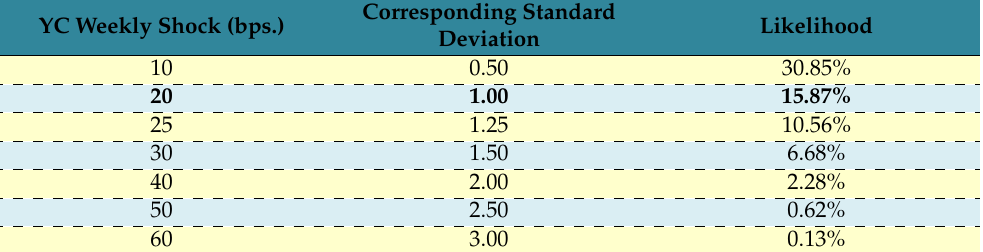
Table 5. Likelihood of principal components’ weekly yield curve shocks on 25 March 2022. YC Weekly Shock (bps.)